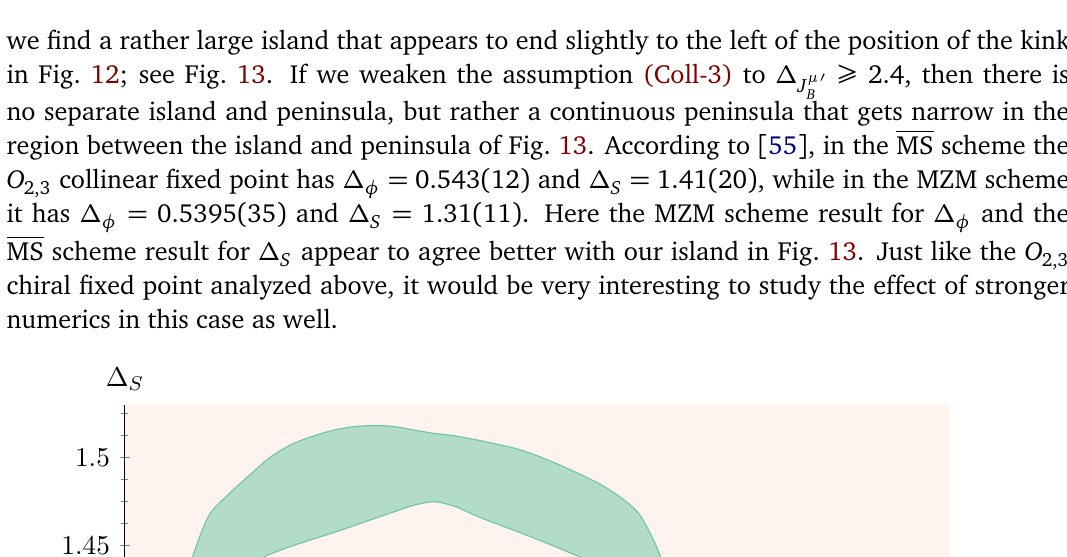
collinear fixed point with the as- 2,3